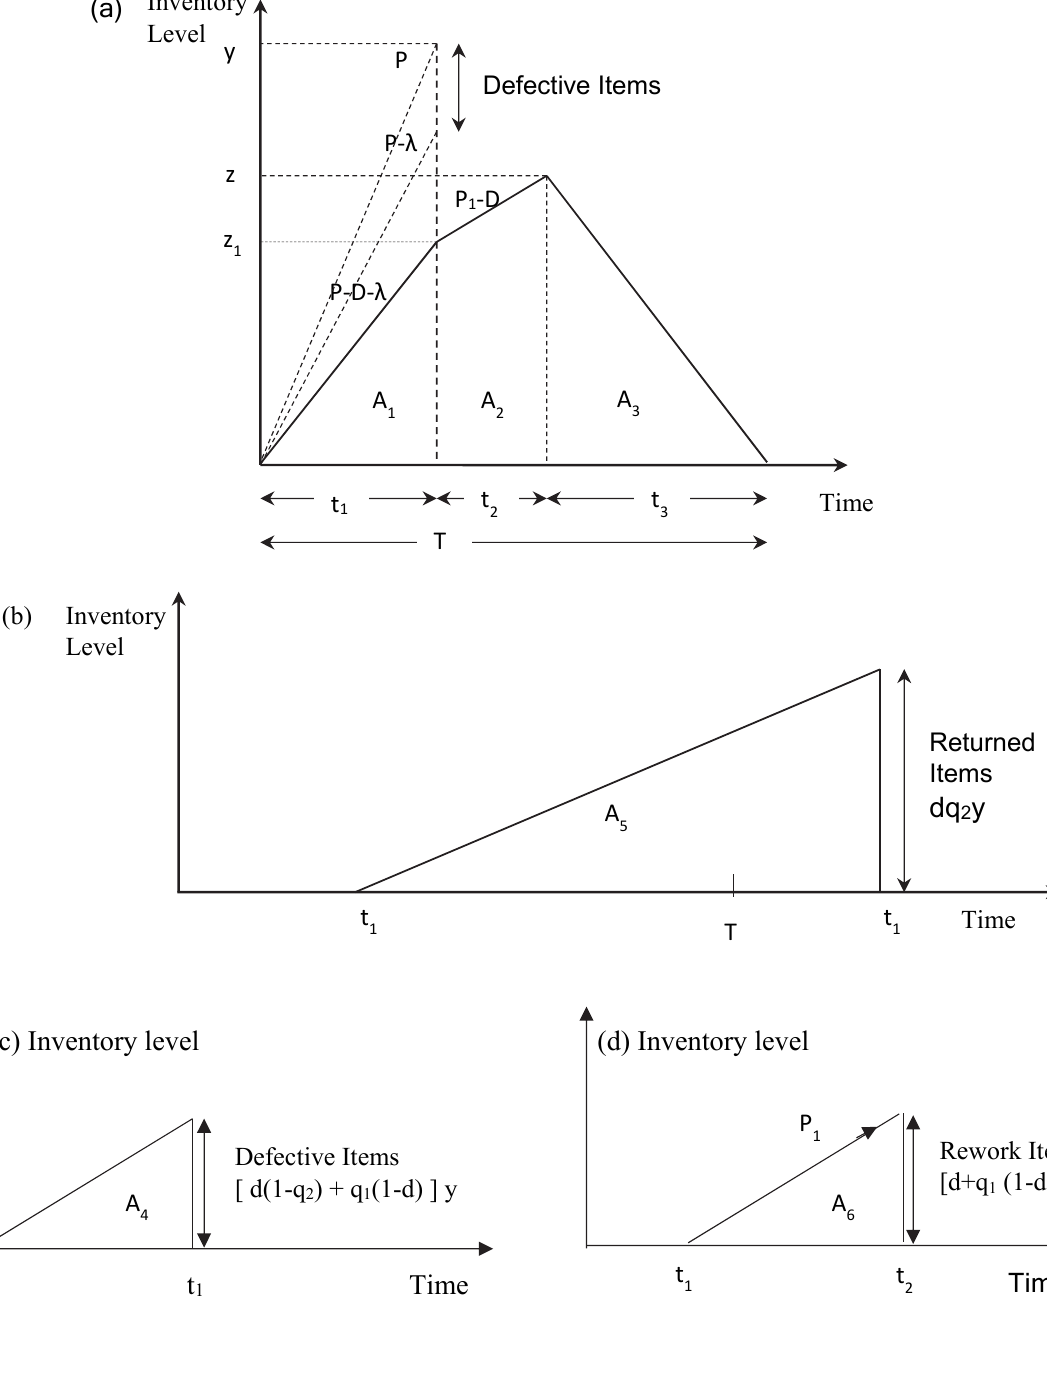
Fig. 2. Inventory behavior of (a) imperfect production and inspection system, (b) defect returns, (c) defective items sorted through inspection process, (d) reworked